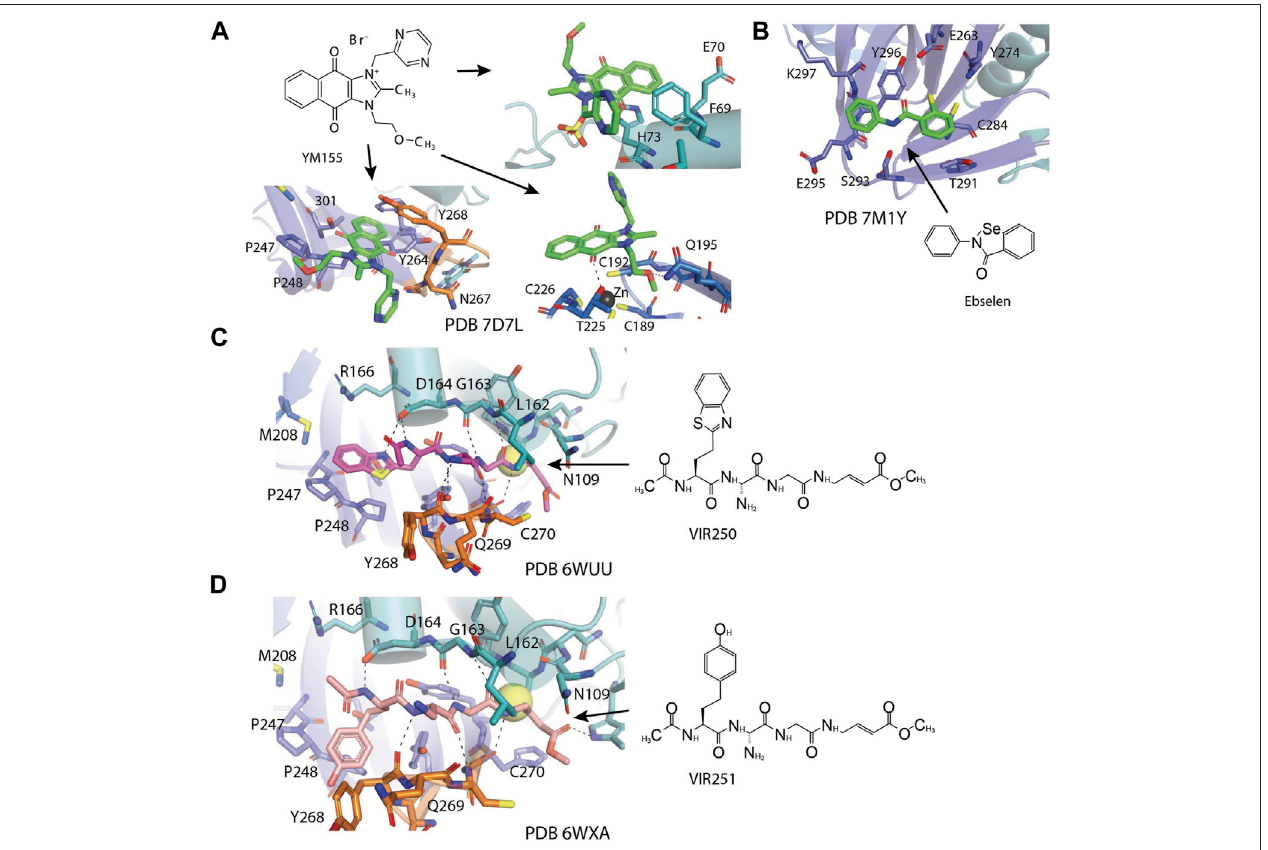
FIGURE 7 | Close-up view of interaction between SARS-CoV-1 PLpro and inhibitors in crystal structures. PLpro is shown as cartoon with sticks representation shownforresiduesinvolvingcontactwithinhibitors.Inhibitorsareshownassticks.Hydrogenbondswerelabeledwithdashed lines. (A) ThreebindingsitesofYM155on SARS-CoV-2 PLpro(PDB:7D7L). (B) SARS-CoV-2 PLpro withebselen(PDB: 7M1Y). (C) SARS-CoV-2PLpro with VIR250 (PDB: 6WUU). (D) SARS-CoV-2PLpro with VIR251 (PDB: